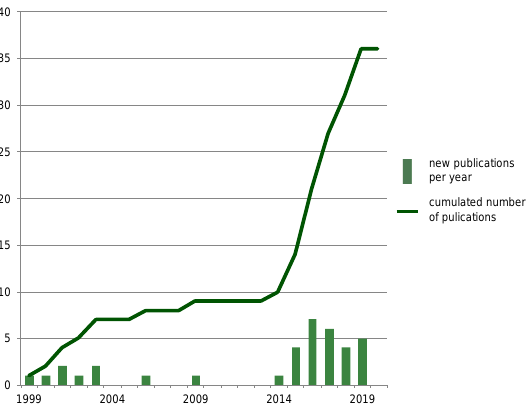
Figure 4. Timeline of published studies. The first included study aiming to determine time since death by means of protein degradation analysis was published in 1999. At around 2015, the number of published articles in this field increased significantly and remained on an elevated level up to